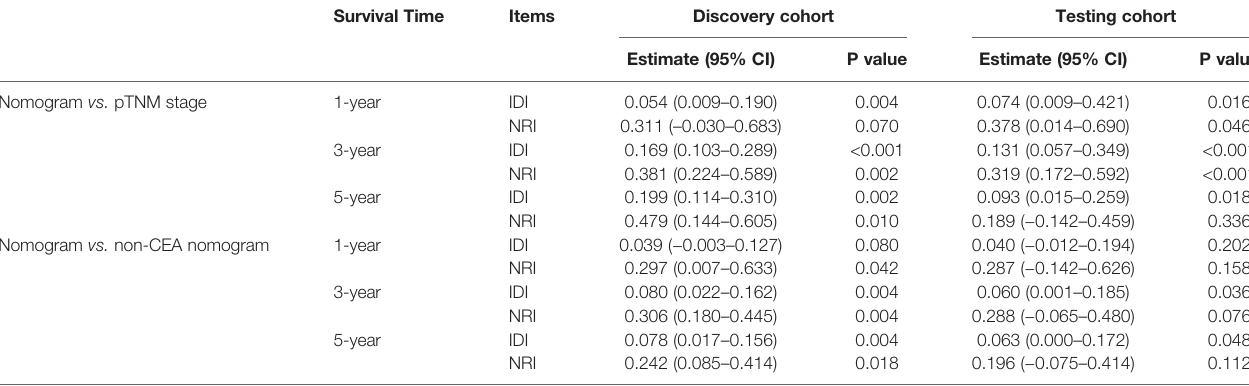
TABLE 2 | Improvement of the nomogram for predicting OS compared with pTNM stage and non-CEA